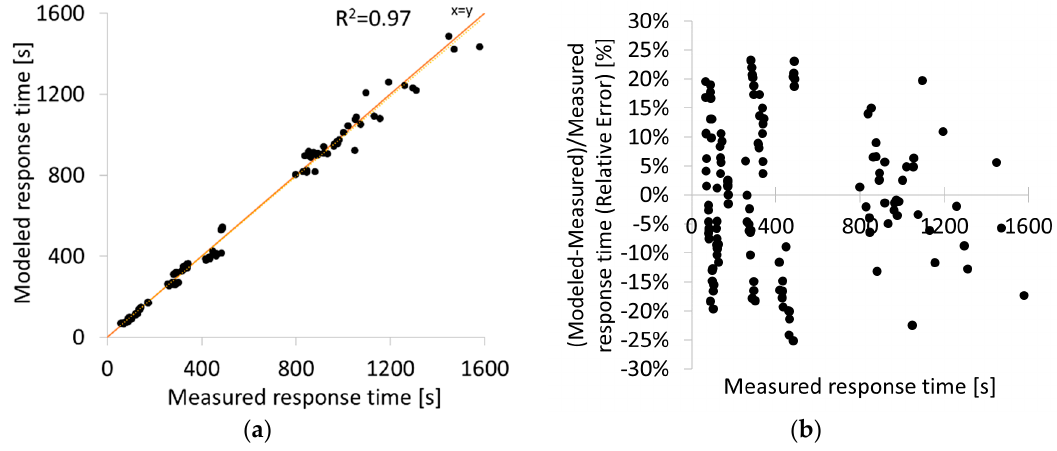
Figure 15. Measured compared to modeled response times in steady-state points, depicted as ( a ) x = y diagram and ( b ) relative error. The maximum error is ±25%.